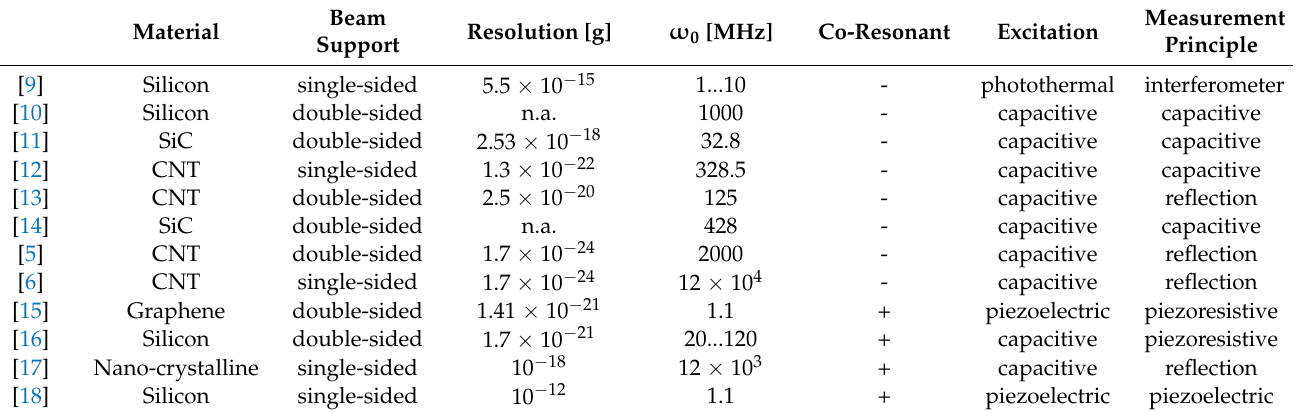
Table 1. Selected publications on resonant nano-mass detection